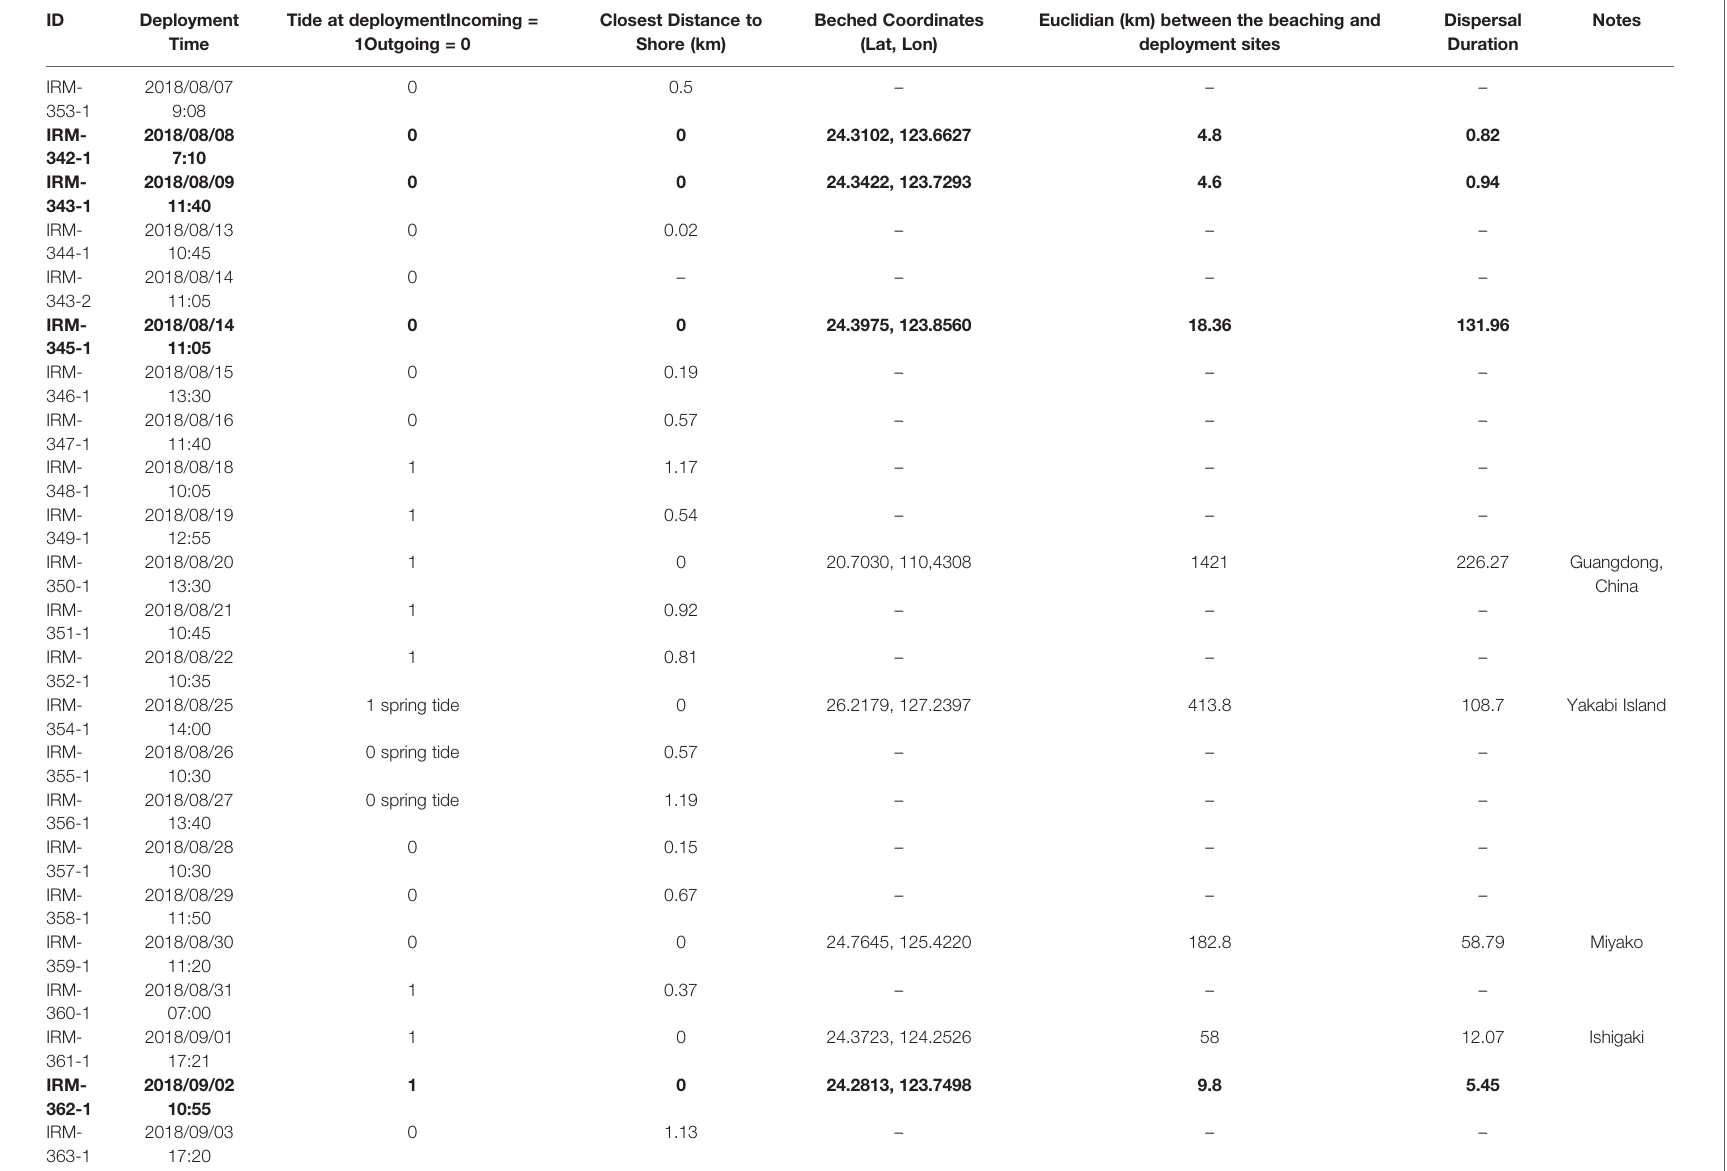
TABLE 3 | In situ drifter experiments showed about 30% of local beaching (Bold letters) with a wide range of temporal variation from 0 to 132